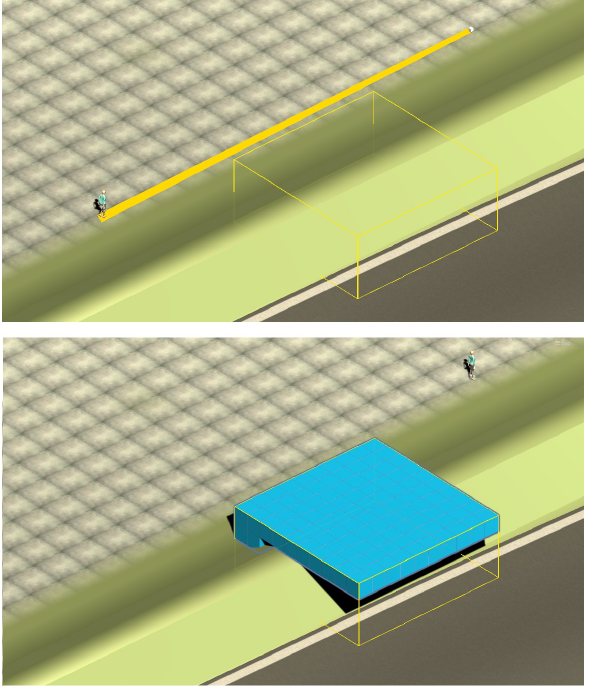
Figure 6. Pathfinding (top image) and impact of terrain on person’s visibility (bottom